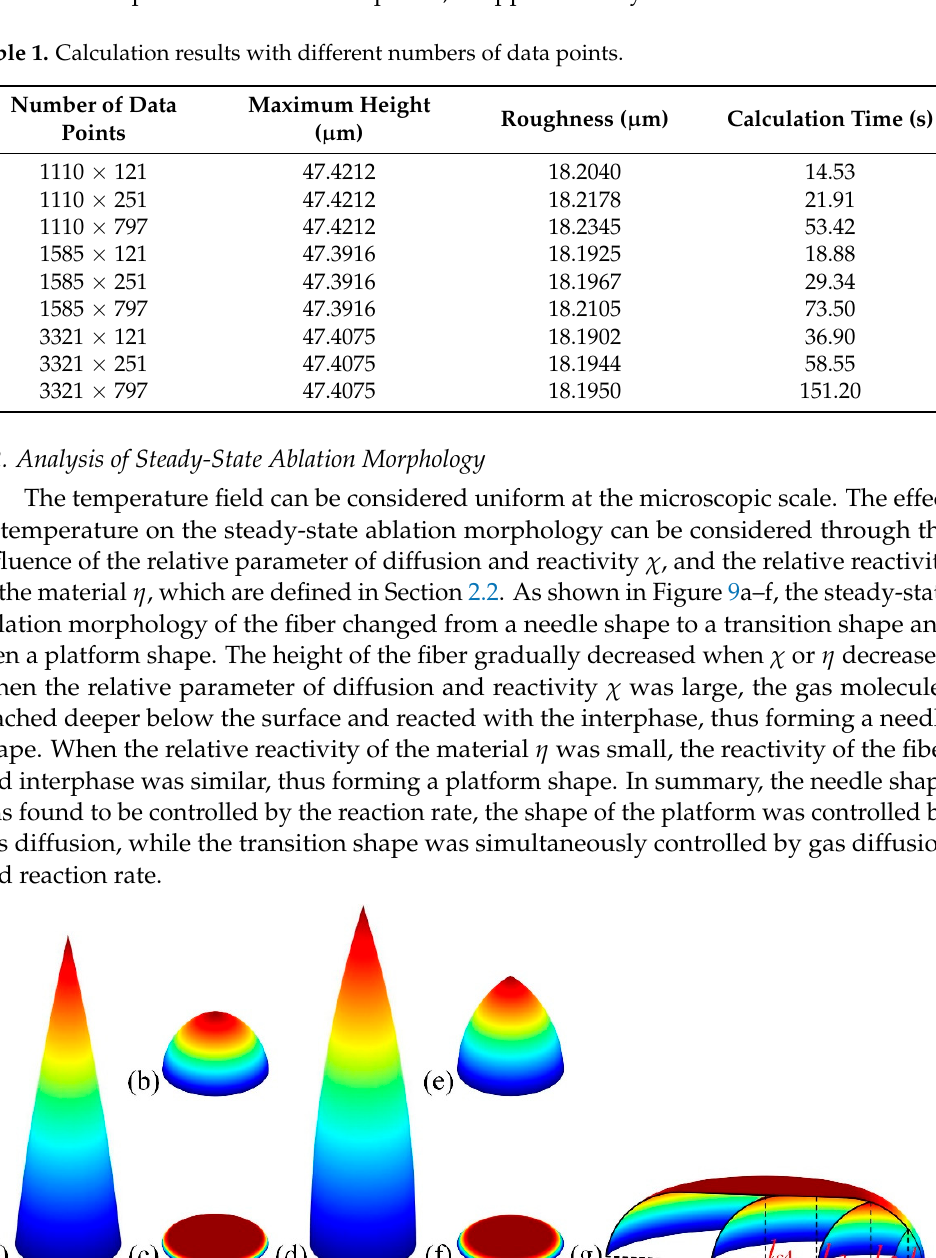
Figure 10. Different cross-sections and their steady-state ablation morphology: ( a – c ) rectangular cross section; ( d – f ) hexagonal cross section; ( g – i ) elliptical cross section. 3.3. Steady-State Ablation Morphology of C/C Composites The reconstruction of the steady-state ablation morphology of carbon fibers has been described previously. Carbon matrix can also be reconstructed in the same way as carbon fibers. Figure 11a shows the SEM morphology of the C/C composites [31]. A simplified section of the fibers and matrix was established by observing the red rectangular area of the SEM morphology, as shown in Figure 11b. Figure 11c,d shows the C/C composite mor- phology and its equipotential map, according to calculation. In this model, the material and environmental parameters were the same as those described in Section 3.1: η f = η m = 20, χ f = χ m = 5 × 10 ‒ 3 m. The calculation results were similar to the SEM morphology of C/C composites. The calculation time was 9.23 s. The characteristic lengths l c of the fibers and matrix were in the ranges of [2.60 × 10 ‒ 6 , 2.95 × 10 ‒ 6 ] m and [4.78 × 10 ‒ 7 , 2.80 × 10 ‒ 6 ] m, respectively. The numbers of fibers and matrix data reflected in the calculation results were 2527 × 31 and 3658 × 31, respectively. The maximum heights of the fibers and matrix were 5.86 × 10 ‒ 5 m and 5.57 × 10 ‒ 5 m, respectively. The morphology of the matrix showed obvious undulations because the characteristic lengths l c of the points in the matrix were different. Owing to the limited depth of field of SEM, only the red and yellow parts may be observed. However, according to the analysis of the steady-state ablation morphology (the maximum characteristic lengths and heights of the fibers and matrix are approxi- mate), the reactivity of the fiber and matrix was approximated by observing the SEM mor- phology. Because the fibers were needle-shaped, the steady-state ablation morphology was limited by the reaction. In addition, according to Equation (9), the roughness Sa = 2.00 × 10 ‒ 5 m. However, roughness is greatly affected by the material and environmental pa- rameters. Thus, the roughness results can only be used as a reference. It is worth noting that the prediction of steady-state ablation morphology can guide the determination of ablation surface roughness to a certain extent when the material and environmental pa- rameters are sufficiently accurate. The calculation results can have a guiding effect on the aerodynamic analysis of aircraft.